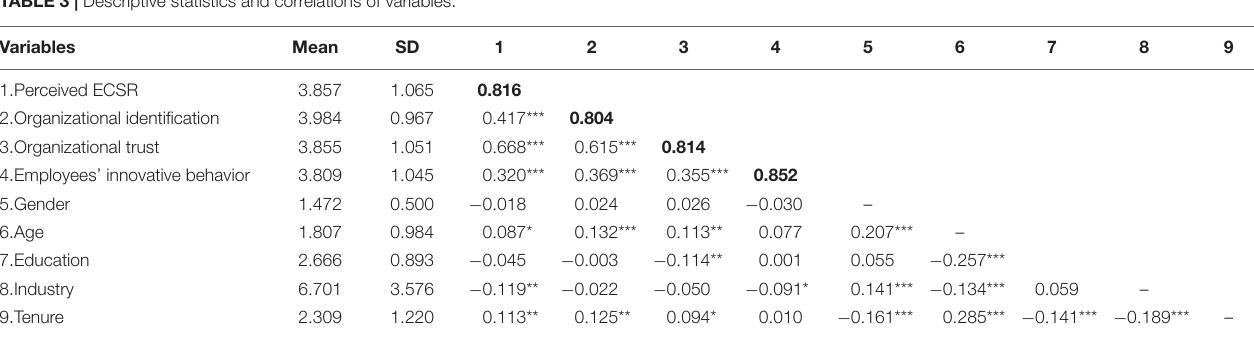
TABLE 3 | Descriptive statistics and correlations of